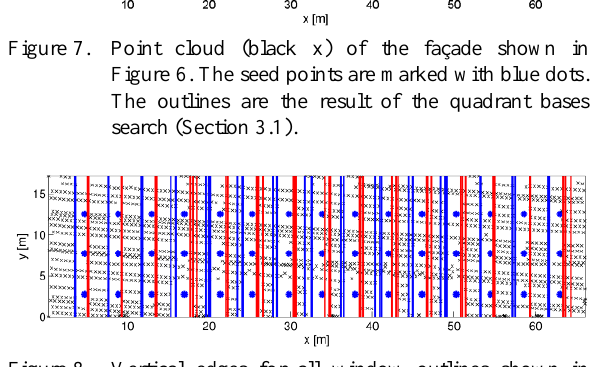
Figure 8. Vertical edges for all window outlines shown in Figure 7, left edges are painted in blue, right edges in red.